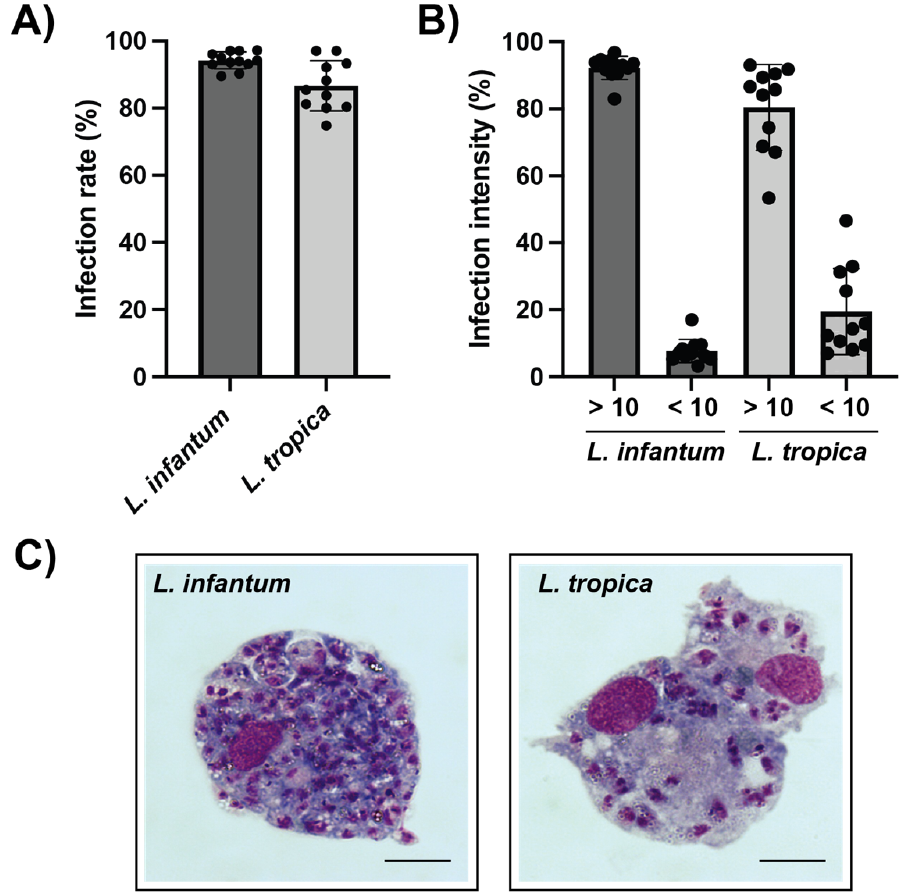
Figure 2. Leishmania spp. infection of differentiated primary canine macrophages. ( A ) Upon ex vivo isolation from whole peripheral blood and further differentiation with PMA, canine monocyte- derived macrophages were infected with L. infantum or L. tropica promastigotes during 72 h at a ratio of 1:10 cells:parasites. The proportion of parasite-bearing cells was quantified through Giemsa staining. ( B ) The intensity of the infection was evaluated by counting the number of intracellular amastigotes within infected macrophages. ( C ) Representative optical images of Giemsa-stained canine macrophages containing L. infantum (left) and L. tropica (right) amastigotes. Note the high number of L. infantum intracellular stages within canine cells. Scale bar 5 µ m. Data (mean ± SD) from four independent experiments are